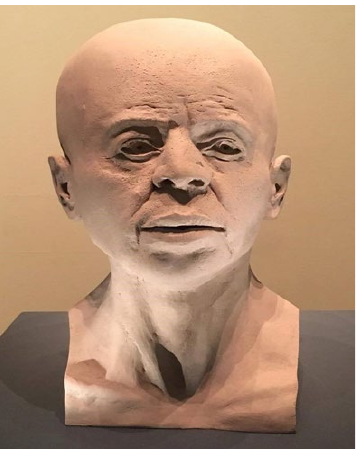
Figure 2: Facial reconstruction of the Jericho Skull (© Trustees of the British Museum) (Voon